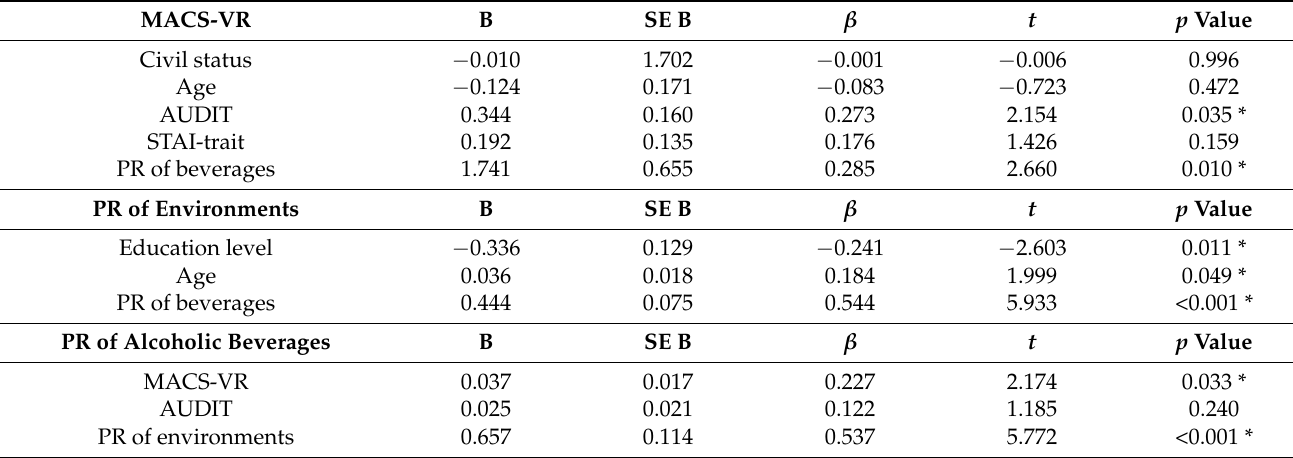
Table 4. Multiple regression analyses with intensity of alcohol craving experienced during VR exposure, PR of environments and PR of alcoholic beverages as the dependent variables.